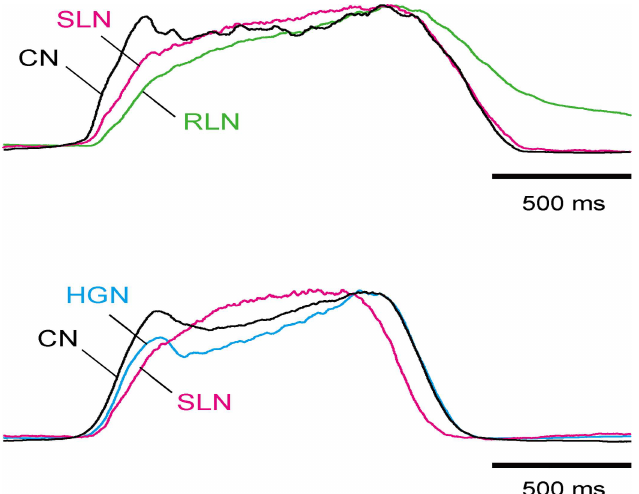
Fig 2. The discharge patterns of the CN, SLN, RLN, and HGN under normocapnic conditions. Averaged traces from two preparations shown in Fig 1 were normalized via the peak